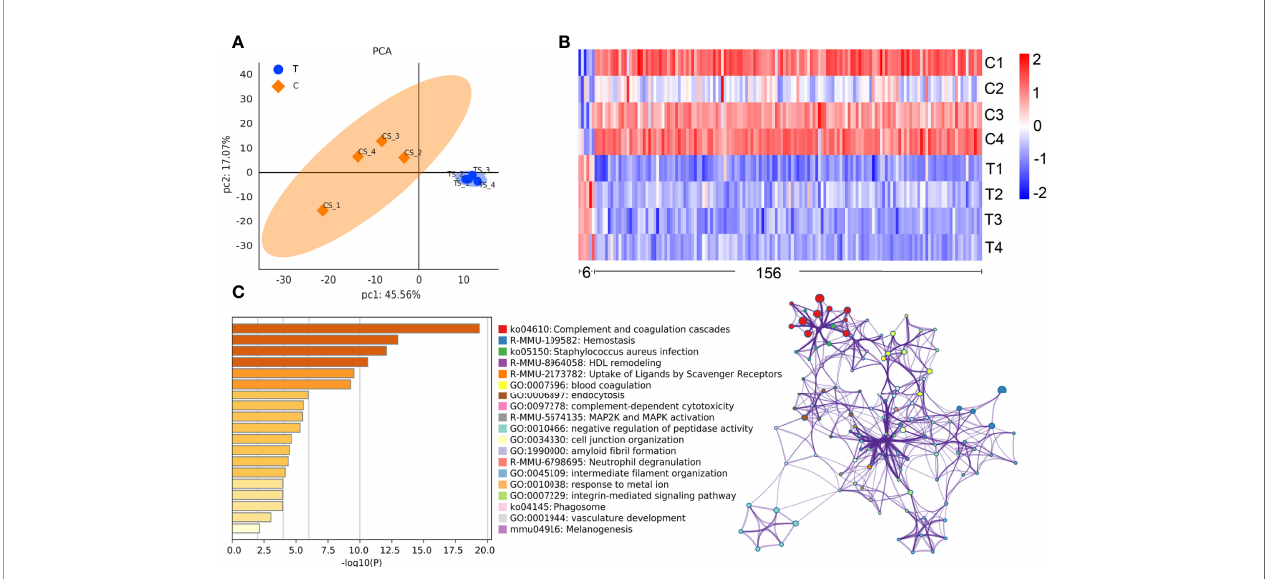
FIGURE 3 | Comparative proteomic analysis. (A) PCA analysis showed that there was a signi fi cant difference between the two groups. (B) The heat map of the differential proteins: The difference screening condition was log10 foldchange = 1 times and p-value < 0.05. The DEPs with foldchange<1 times were selected as downregulated proteins, that of >1 times were selected as upregulated proteins, including 6 upregulated ones and 156 downregulated ones. (C) The top enrichment 20 terms according to -log10 p value made by Metascape online